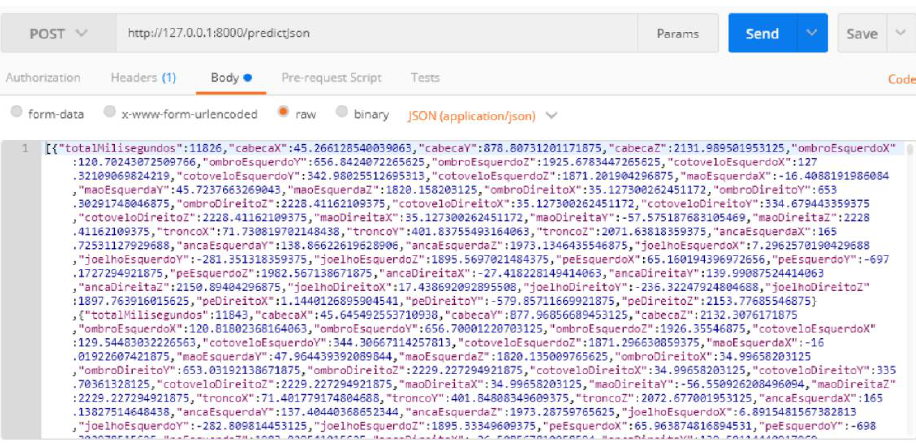
Figure 17. POST inference.